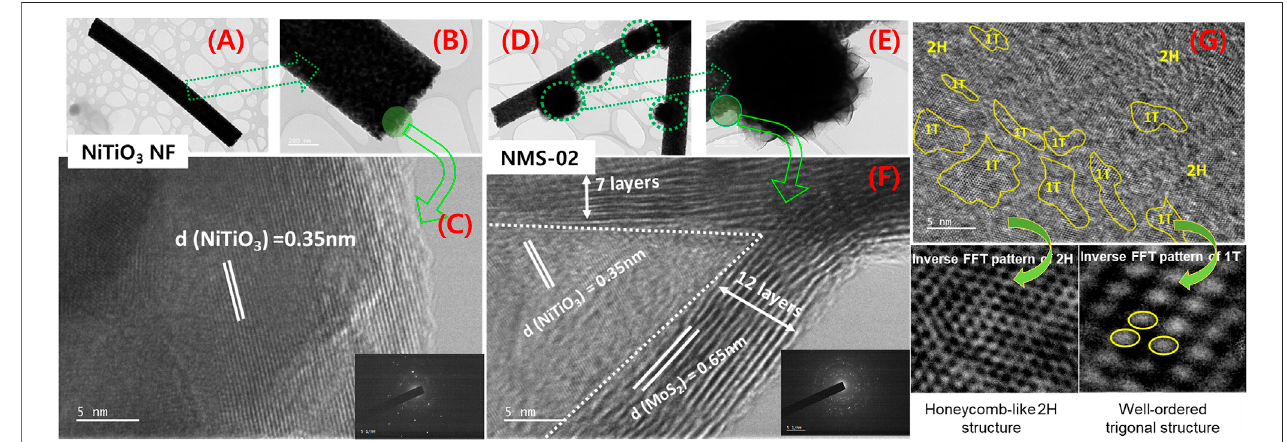
FIGURE 2 | Transmission electron microscope images of microstructures. Pristine NiTiO 3 nano fi bers at (A,B) low and (C) high resolution indicating interplanar d-spacing, NMS-02 hybrid structure at (D,E) low and (F) high resolution showing interplanar d-spacings and the number of layers of MoS 2 , and (G) inverse fast Fourier transform patterns revealing the co-existence of honeycomb-like 2H and well-ordered trigonal structures in the NMS-02 hybrid structure.